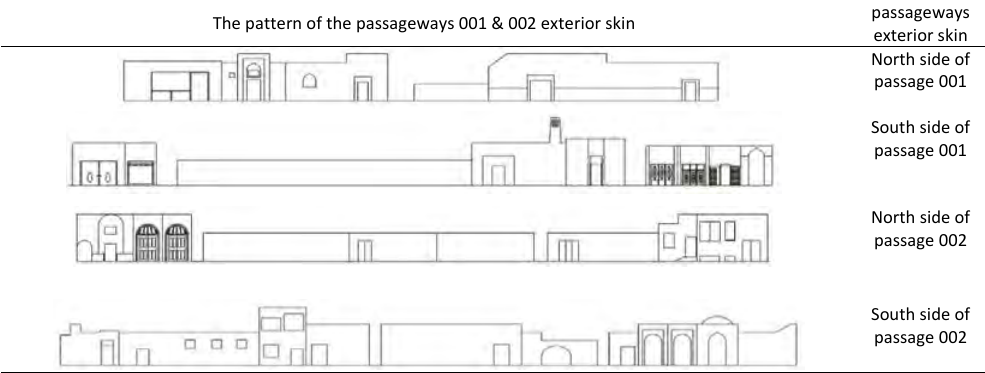
Table 8: The pattern of passageways exterior skin in Shah Abolghasem district of Yazd